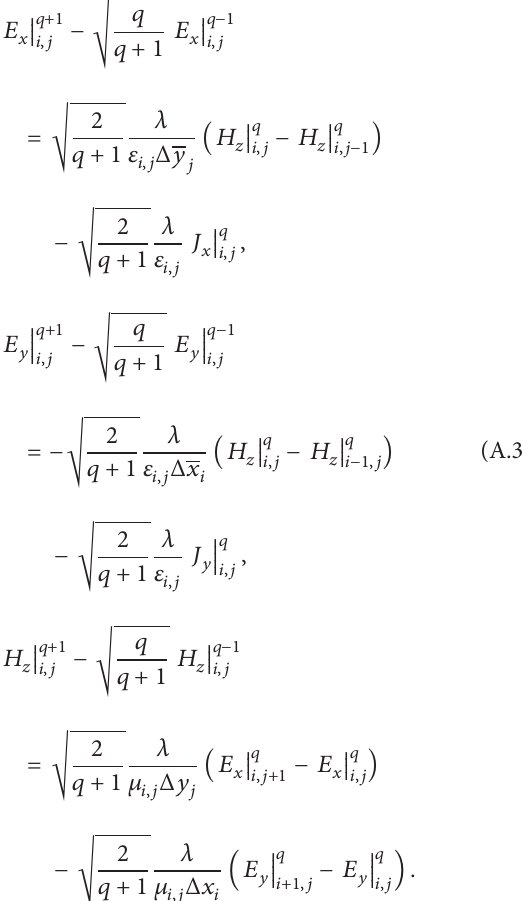
Figure 7: Influence of different order 𝑄 affecting the accuracy.